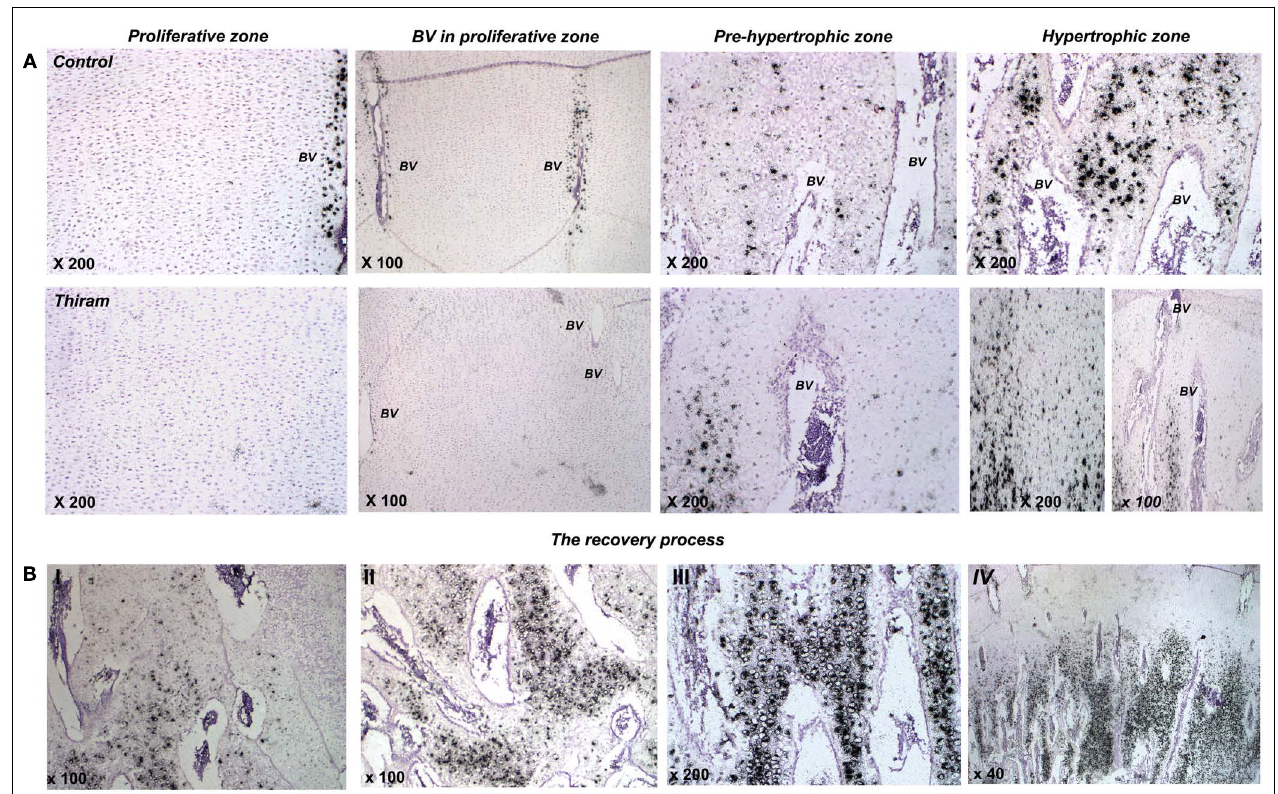
FIGURE 4 |Thiram effects cell morphology and MGP expression in the growth plate. (A) The effect of thiram on MGP expression in the proliferative zone, around blood vessels in the proliferative zone, pre-hypertrophic, and hypertrophic zones. (B) Stages of the recovery process. I, most impaired; IV, most healed.